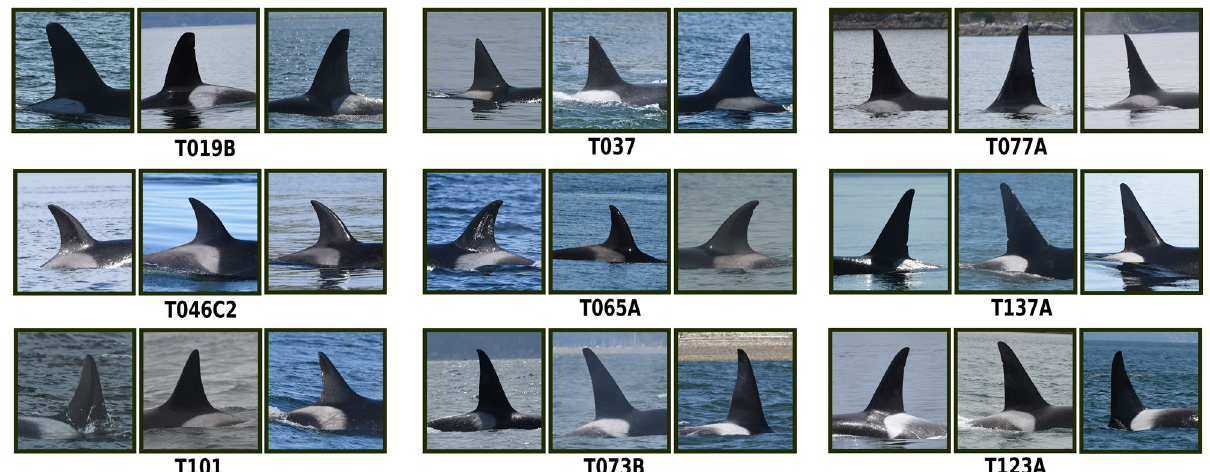
Figure 6. Examples of detected (FIN-DETECT), extracted (FIN-EXTRACT), and pre-filtered (VVI-DETECT) unseen and valid killer whale identification images from 2018 which were successfully classified by FIN- IDENTIFY, trained on